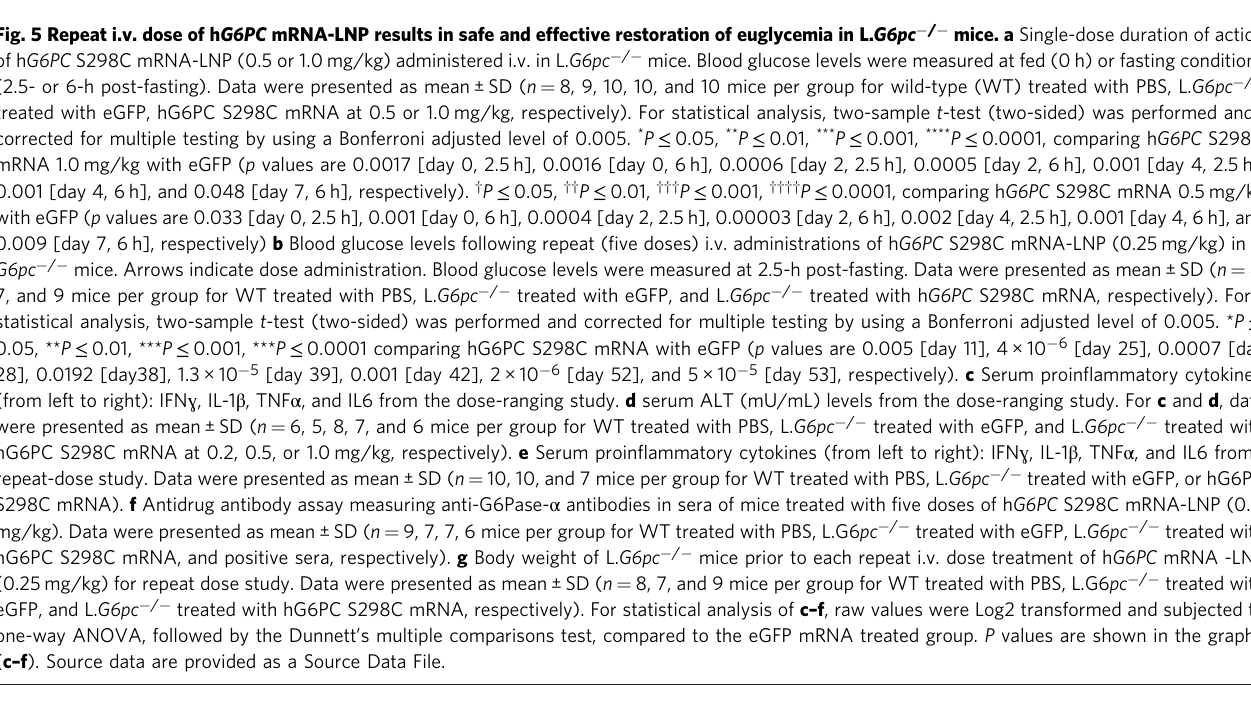
Fig. 5 Repeat i.v. dose of h G6PC mRNA-LNP results in safe and effective restoration of euglycemia in L. G6pc − / − mice. a Single-dose duration of action of h G6PC S298C mRNA-LNP (0.5 or 1.0 mg/kg) administered i.v. in L. G6pc − / − mice. Blood glucose levels were measured at fed (0 h) or fasting conditions (2.5- or 6-h post-fasting). Data were presented as mean ± SD ( n = 8, 9, 10, 10, and 10 mice per group for wild-type (WT) treated with PBS, L. G6pc − / − treated with eGFP, hG6PC S298C mRNA at 0.5 or 1.0 mg/kg, respectively). For statistical analysis, two-sample t -test (two-sided) was performed